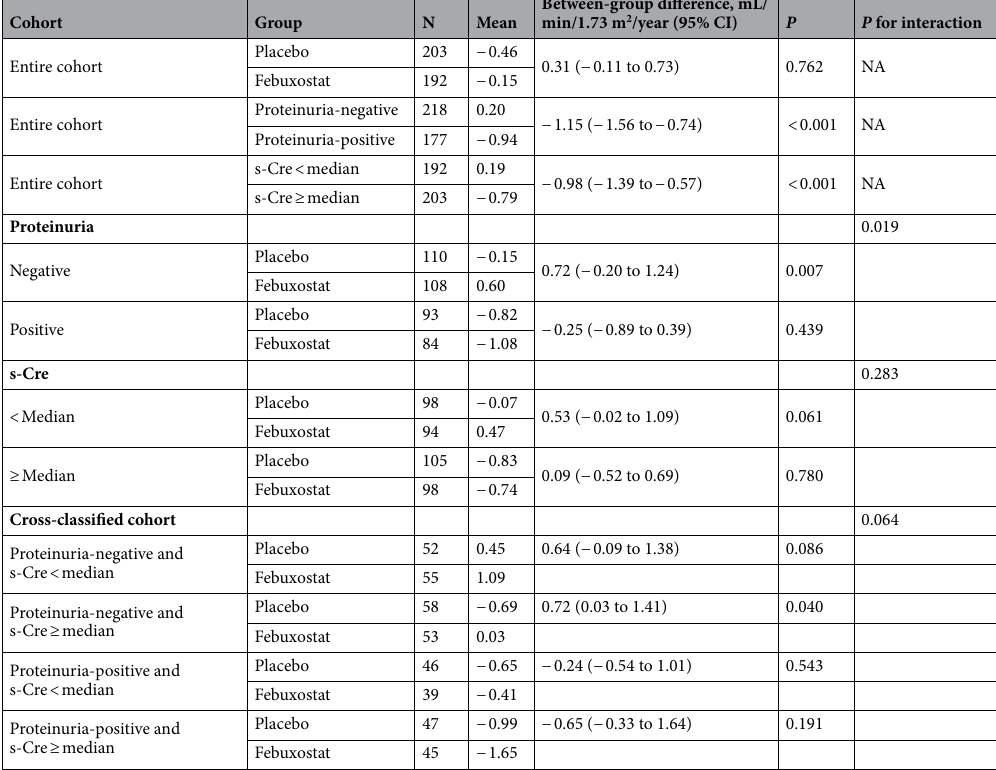
Table 2. Analysis of the eGFR slopes. CI confidence interval, eGFR estimated glomerular filtration rate, s-Cre serum